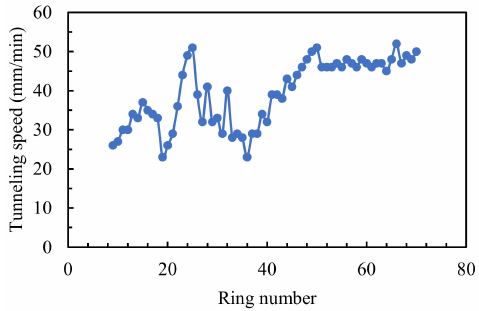
Figure 15. Variation in the tunneling